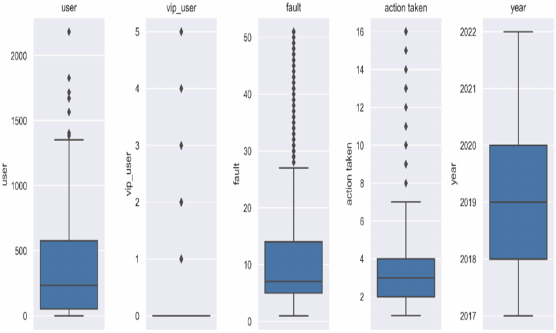
Figure 3. Box plot of the data collected from Tabuk grid station.